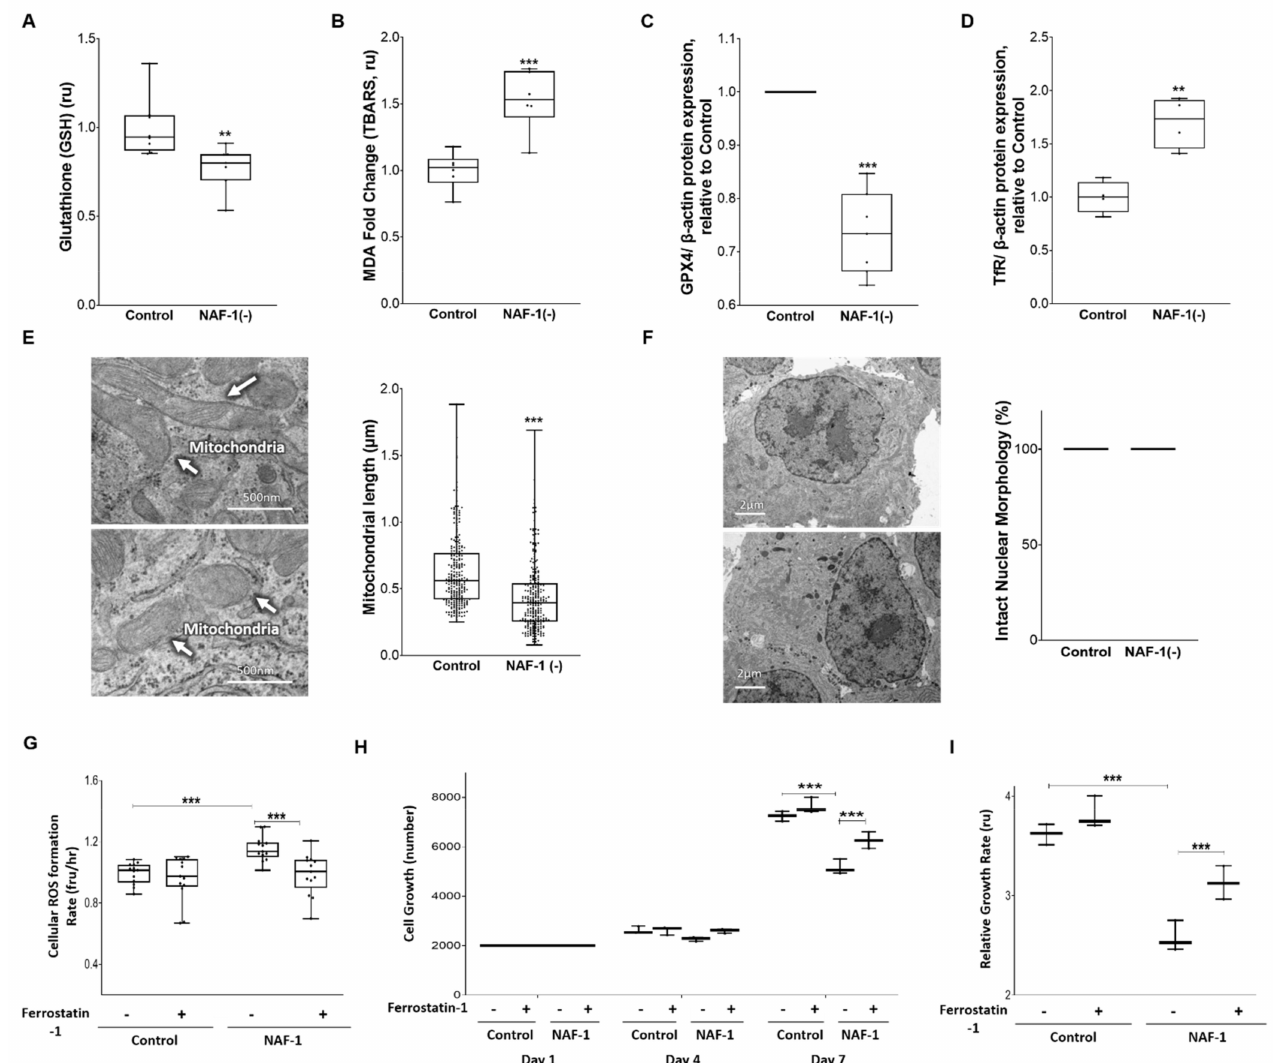
Figure 8. Presence of ferroptosis-like symptoms in NAF-1( − ) pancreatic cells. Reduced glutathione (GSH) levels ( A ), increased lipid peroxidation ( B ), decreased GPX4 expression ( C ), enhanced TfR expression ( D ), and shortened mitochondria ( E ) (repre- sentative image: top, control; bottom, NAF-1-deficient) in control and NAF-1( − ) pancreatic cells. ( F ) Morphology of nuclei in control and NAF-1( − ) cells (representative image: top, control; bottom, NAF-1-deficient). ( G ) Cellular ROS levels in control and NAF-1( − ) cells in the presence or absence of 2 µ M, ferrostatin-1. ( H , I ) cell growth of control and NAF-1( − ) cells (measured by counting cell numbers ( H ) or using PrestoBlue TM ( I )) in the presence or absence 2 µ M ferrostatin-1. The results are shown as box-and-whisker plots and include all data points measured from three different experiments. ** p < 0.01, *** p < 0.001, compared to control; Student’s t -test, N = 3 for ( A , B , G , H , I ), N = 5 for ( C , D ), N = 250 for ( E ), N = 10 for ( F ). Abbreviations: GSH, reduced glutathione; MDA, malondialdehyde; GPX4, glutathione peroxidase 4; TfR, transferrin